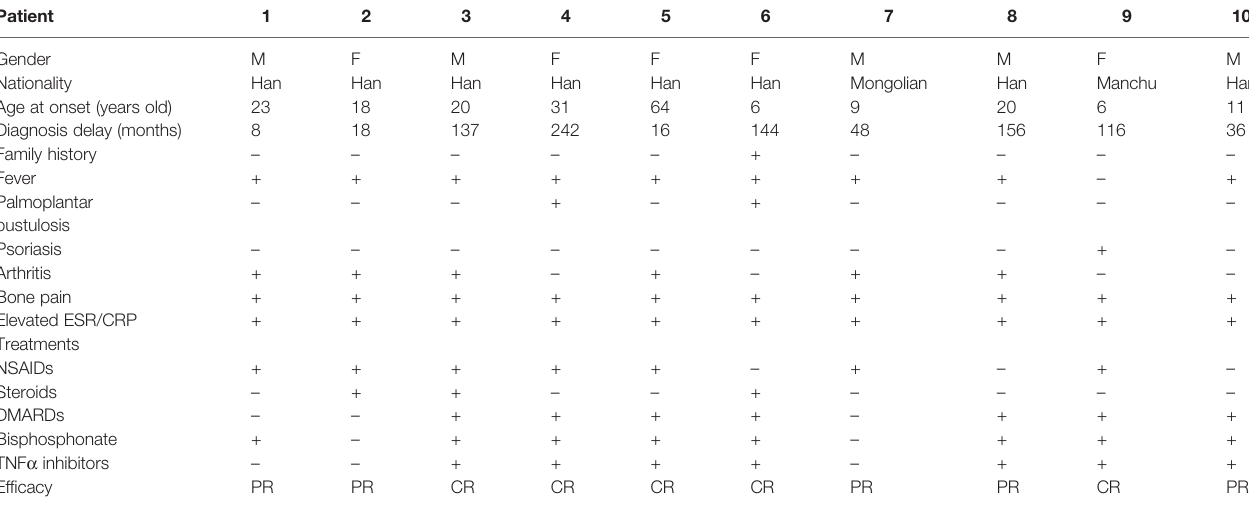
TABLE 1 | Baseline demographic data and clinical features of Chinese adult patients with